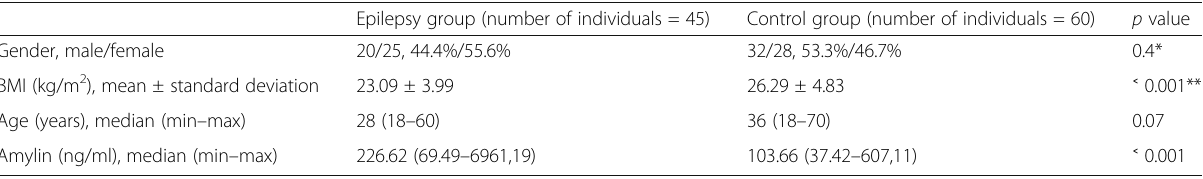
Table 1 Comparison of study variables between epileptic patients and controls Epilepsy group (number of individuals = 45) Control group (number of individuals = 60) p value Gender,